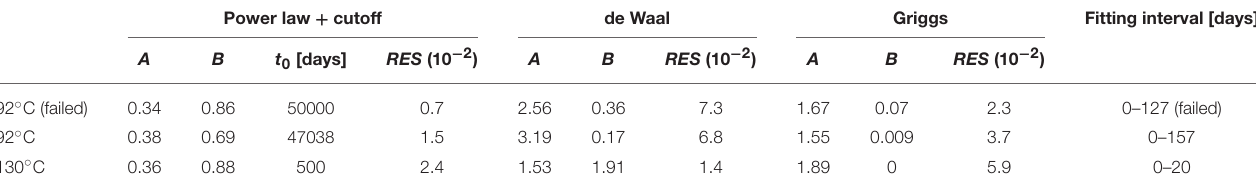
TABLE 5 | Fitting parameters for the primary creep curve, i.e., with monotonous decreasing strain rate, in the 12.3MPa experiments. Power law + cutoff de Waal Griggs Fitting interval [days]